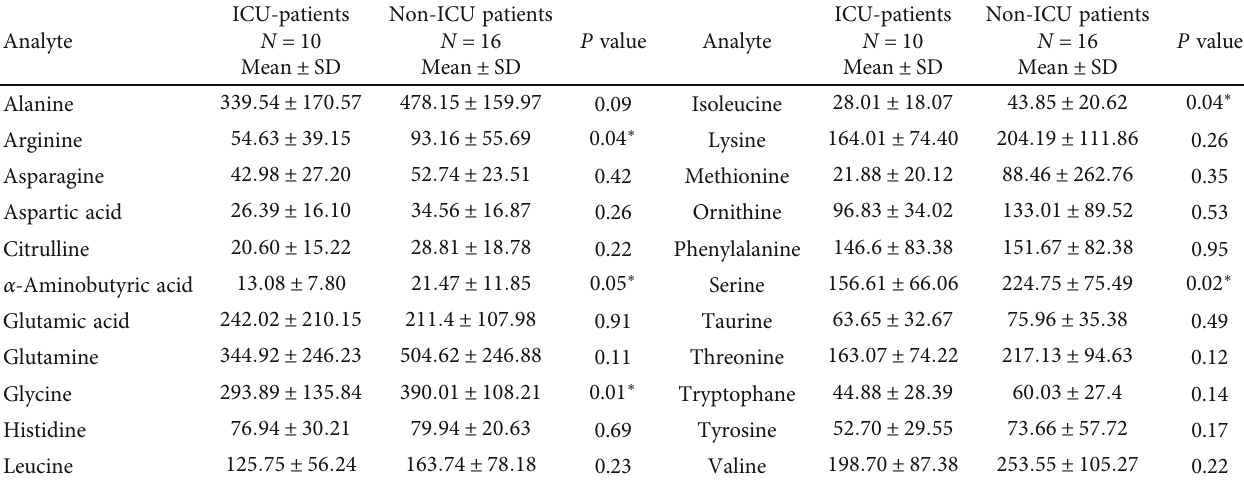
Table 3: Comparison of amino acids concentration ( μ mol/L) between ICU and non-ICU patients.